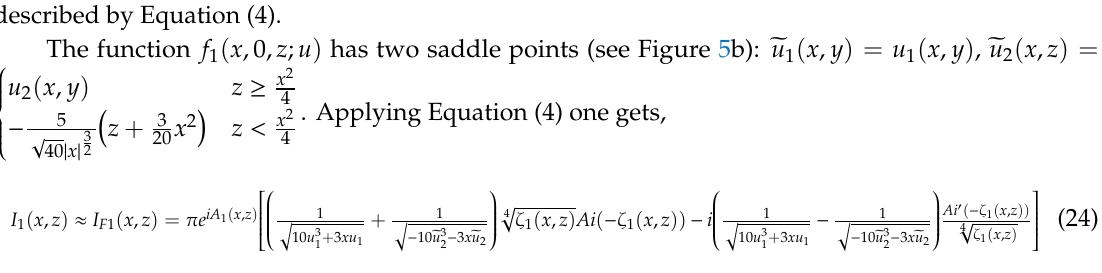
( b) , Figure 5. Saddle points ( u